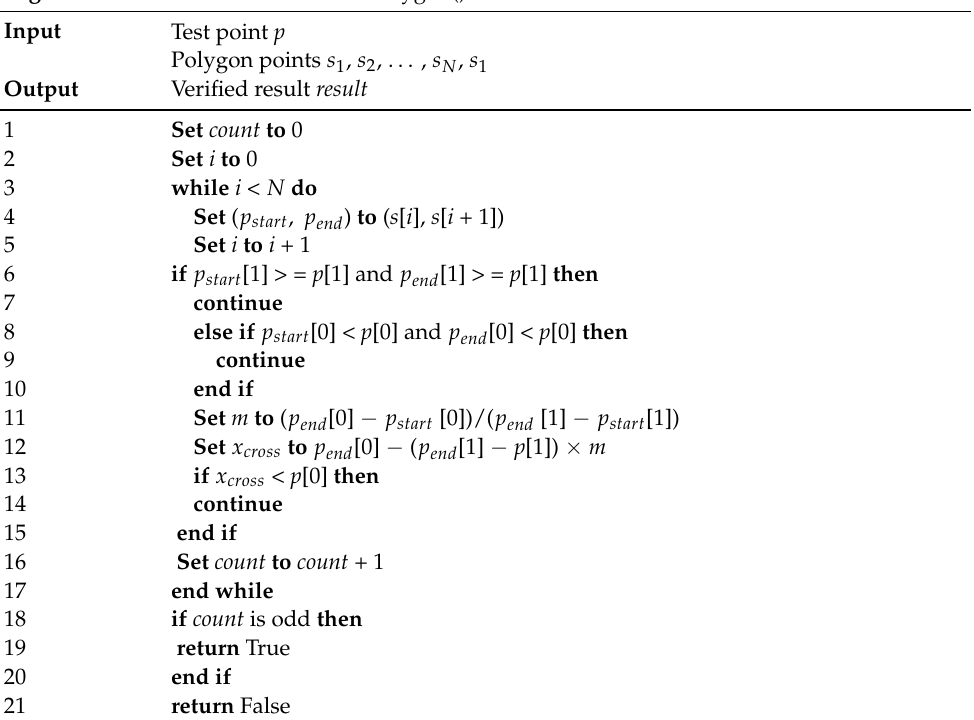
Algorithm 2 Function is